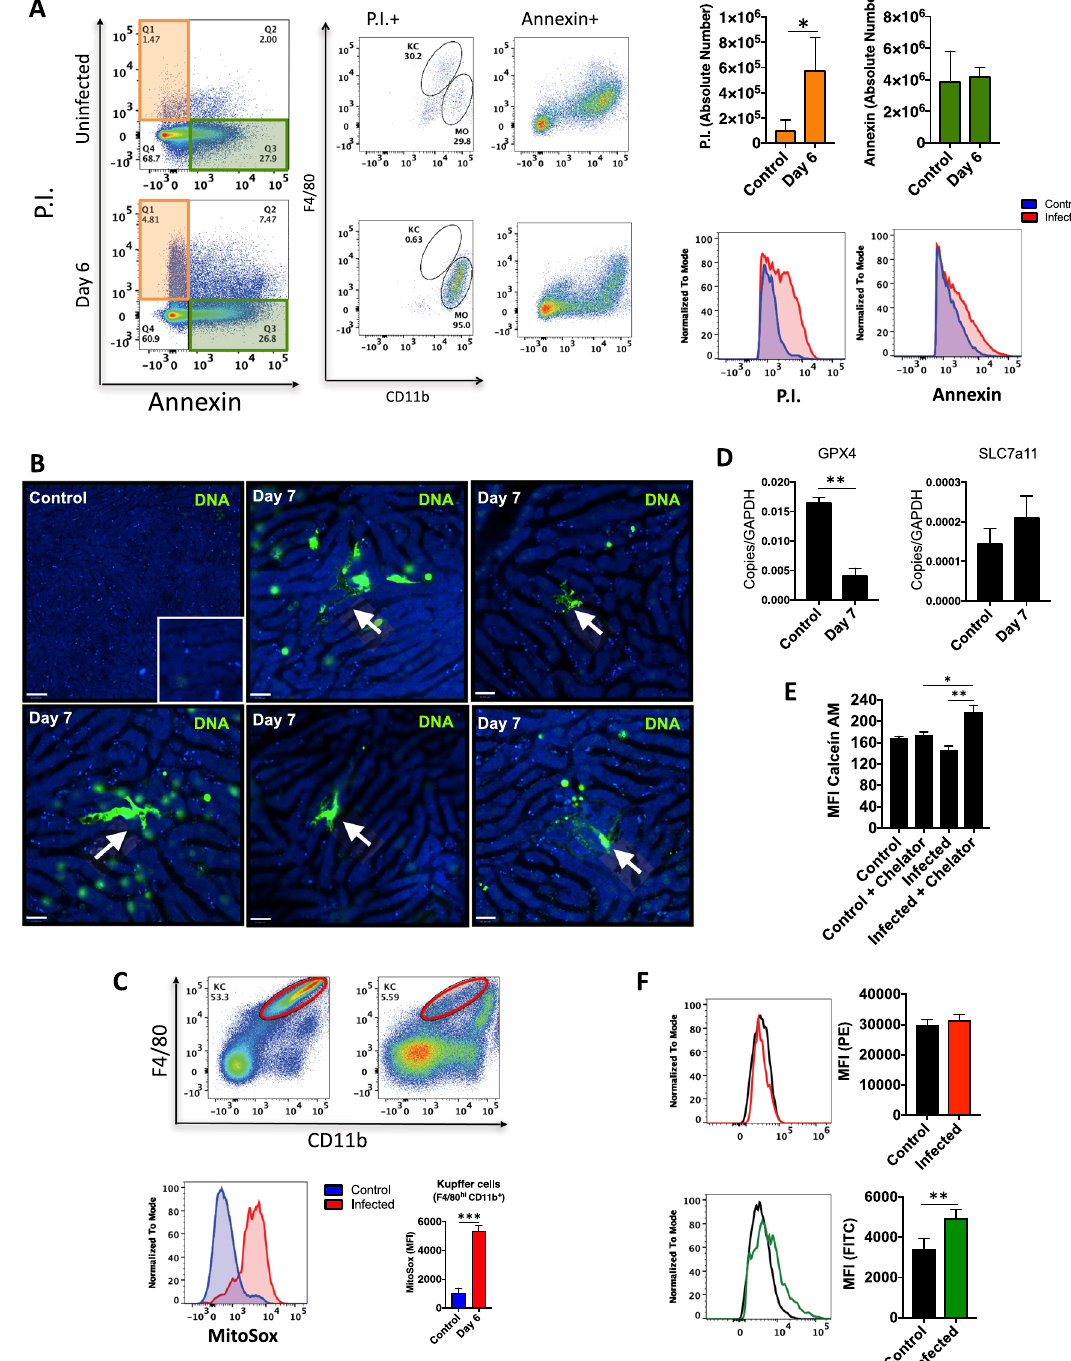
Figure 6. Hemozoin induces Kupffer cells death through ferroptosis. ( A ) Dot plot showing apoptosis and necrosis in the liver. Bars graphs correspond to absolute number of cell death by necrosis or apoptosis (n = 4). ( B ) In vivo extracellular DNA release, ( C ) Mitochondrial superoxide (n = 5), ( D ) GPX4 and SLC7a11 mRNA from liver non-parenchymal cells (n = 6), and ( E ) Intracellular free iron levels in Kupffer cells (n = 3). The data shown are representative of 3 independent experiments. Data expressed as mean ± SD. Statistical significance comparing infected and non-infected mice (one-way ANOVA, * p < 0.05, ** p < 0.01). ( F ) Lipid peroxidation. Statistical significance comparing infected and non-infected mice (Student’s t test, * p < 0.05, ** p <